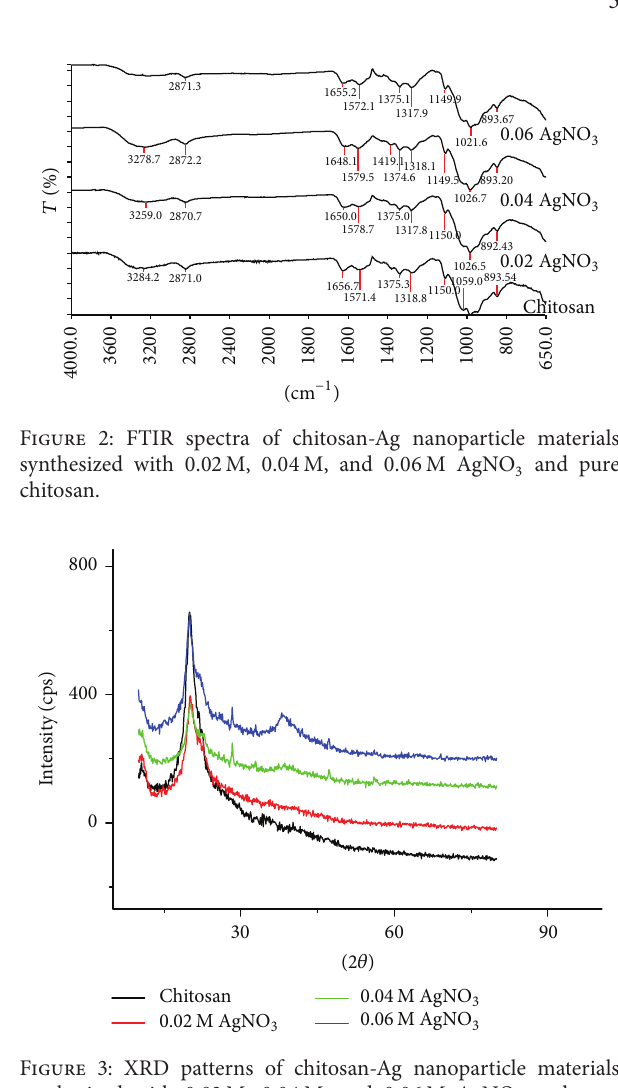
Figure 3: XRD patterns of chitosan-Ag nanoparticle materials synthesized with 0.02 M, 0.04 M, and 0.06 M AgNO 3 and pure